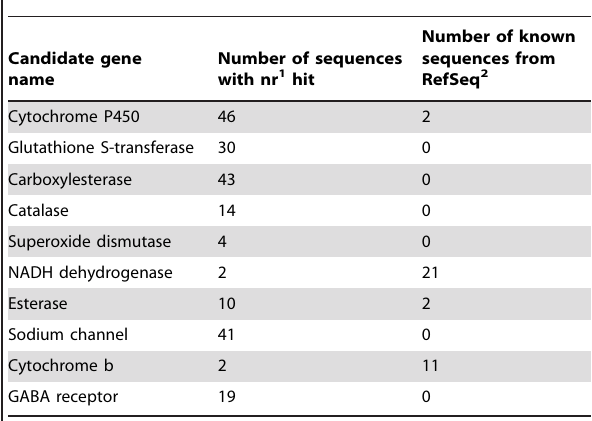
Table 2. Genes involved in insecticide metabolism.